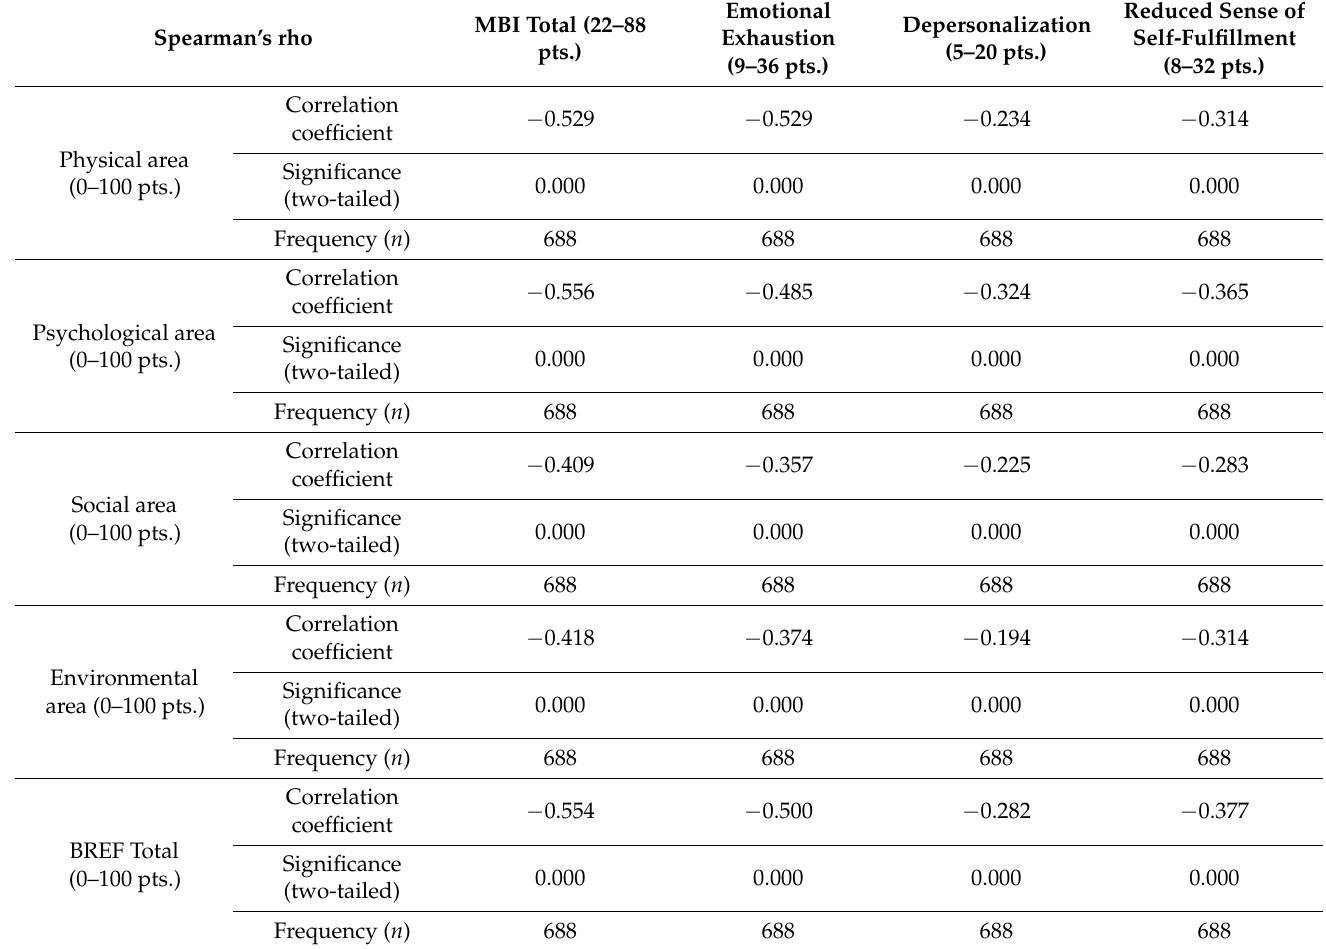
Table 4. Correlation results between MBI occupational burnout and WHOQOL-BREF quality of life